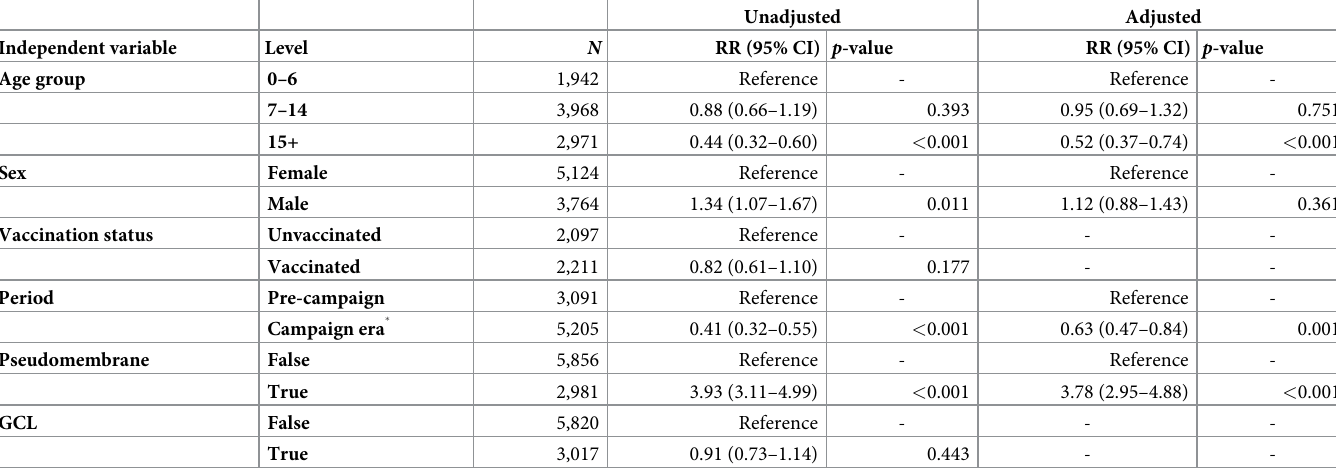
Table 4. Multivariable Poisson regression for predictors for diphtheria patients testing positive (as opposed to negative) for toxigenic C . diphtheriae strain by PCR, Cox’s Bazar, Bangladesh, November 10, 2017 to November 10,